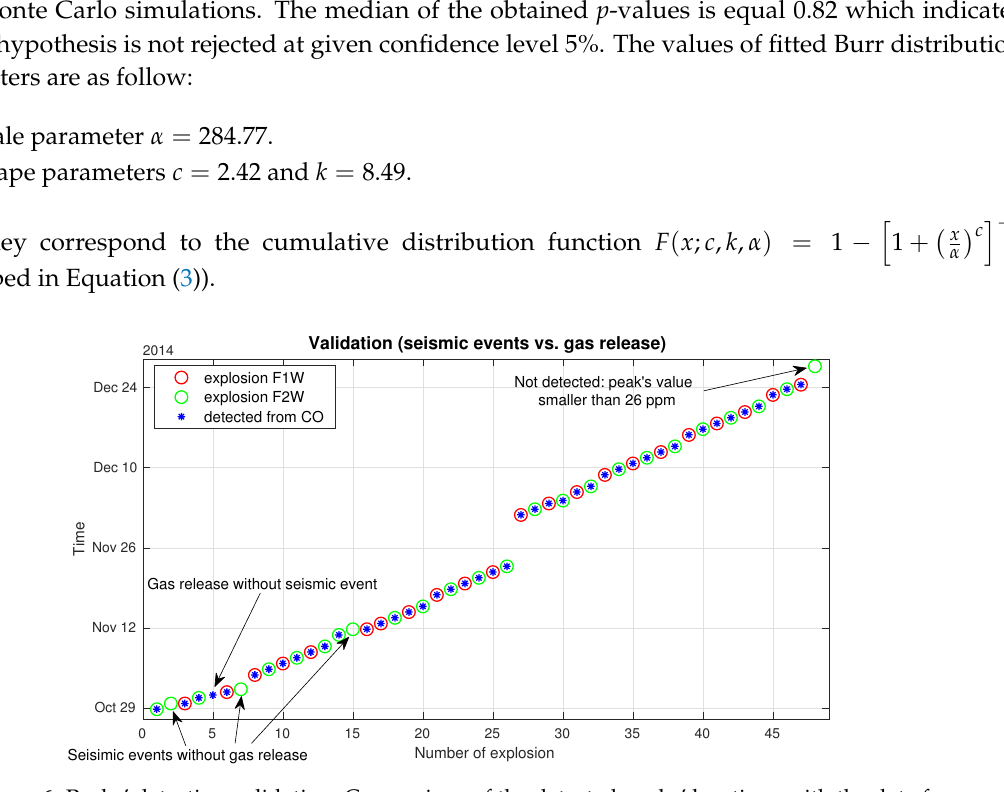
Figure 6. Peaks’ detection validation: Comparison of the detected peaks’ locations with the data from the seismic monitoring